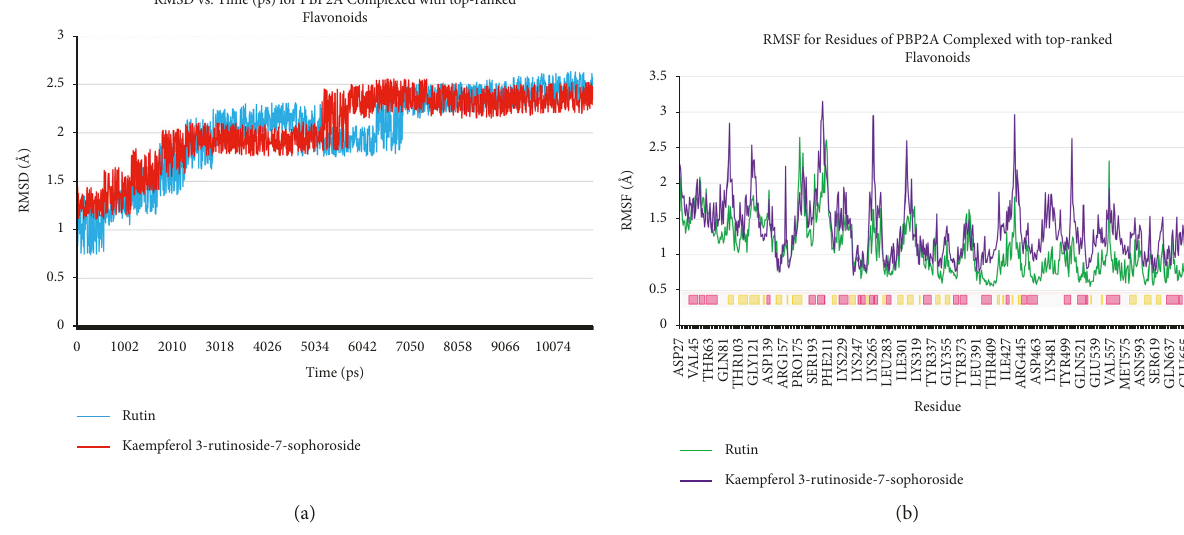
Figure 7: (a) Time evolution of RMSD of backbone atoms and (b) RMSF for SauPBP2a complexed with kaempferol 3-rutinoside-7- sophoroside and rutin. The secondary structure of the protein was achieved from the RCSB database. Pink and yellow colors illustrate helics and beta-strand structures, respectively. RMSD, root mean square deviations; RMSF, root mean square